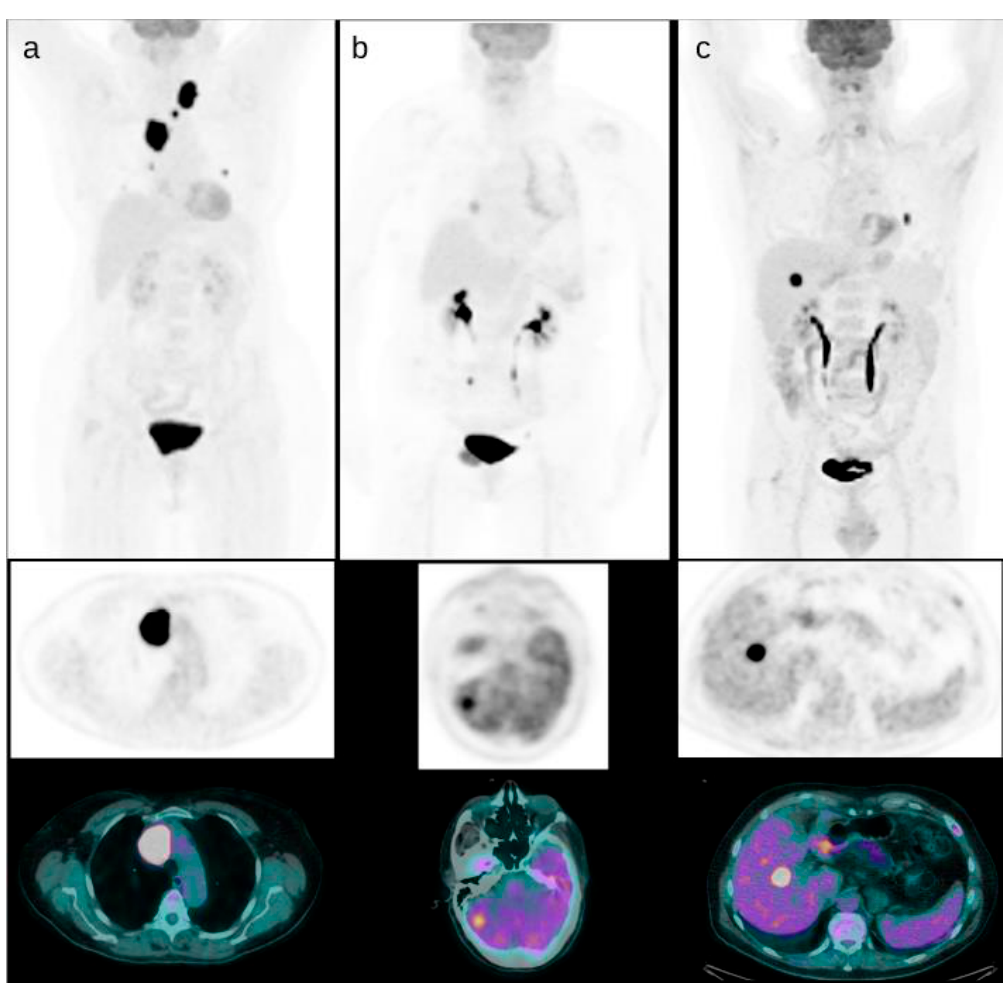
Figure 2. Some examples of DTC patients with positive PET/CT. A patient with mediastinal and thoracic FDG positive disease and the lesion with higher uptake in the upper mediastinum ( a , SUVmax 55). A patient with brain metastases detected by PET/CT with uptake higher than the surrounding brain parenchyma ( b , SUVmax 20). A patient with liver metastases ( c , SUVmax 35).